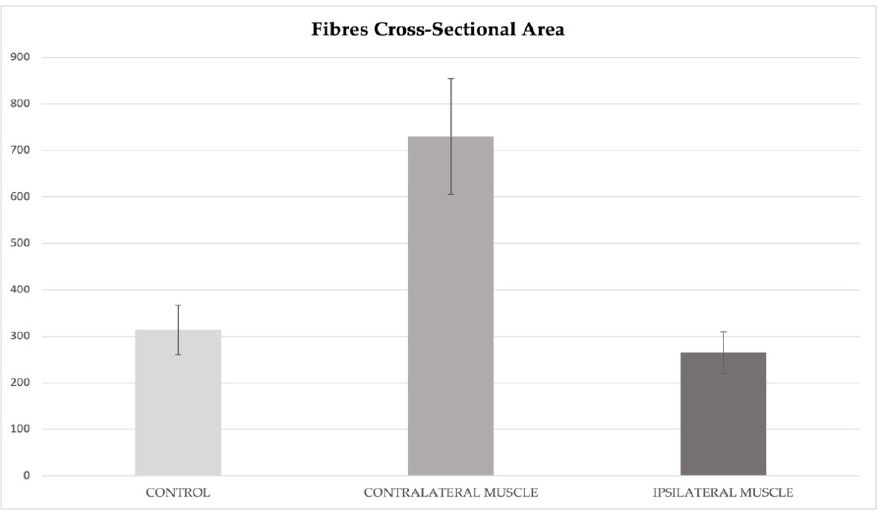
Figure 2. Histogram showing the mean values of fiber diameters in control, contralateral and ipsilateral muscles: means were 22.2 μ m, 32.4 μ m, and 18.4 μ m, respectively. The bar error corresponds to the standard deviation. The differences are statistically significant in the following comparisons: control–contralateral with a p -value = 0.04 and contralateral–ipsilateral with a p -value = 0.02. The difference between control and ipsilateral is not statistically significant with a p -value = 0.08.